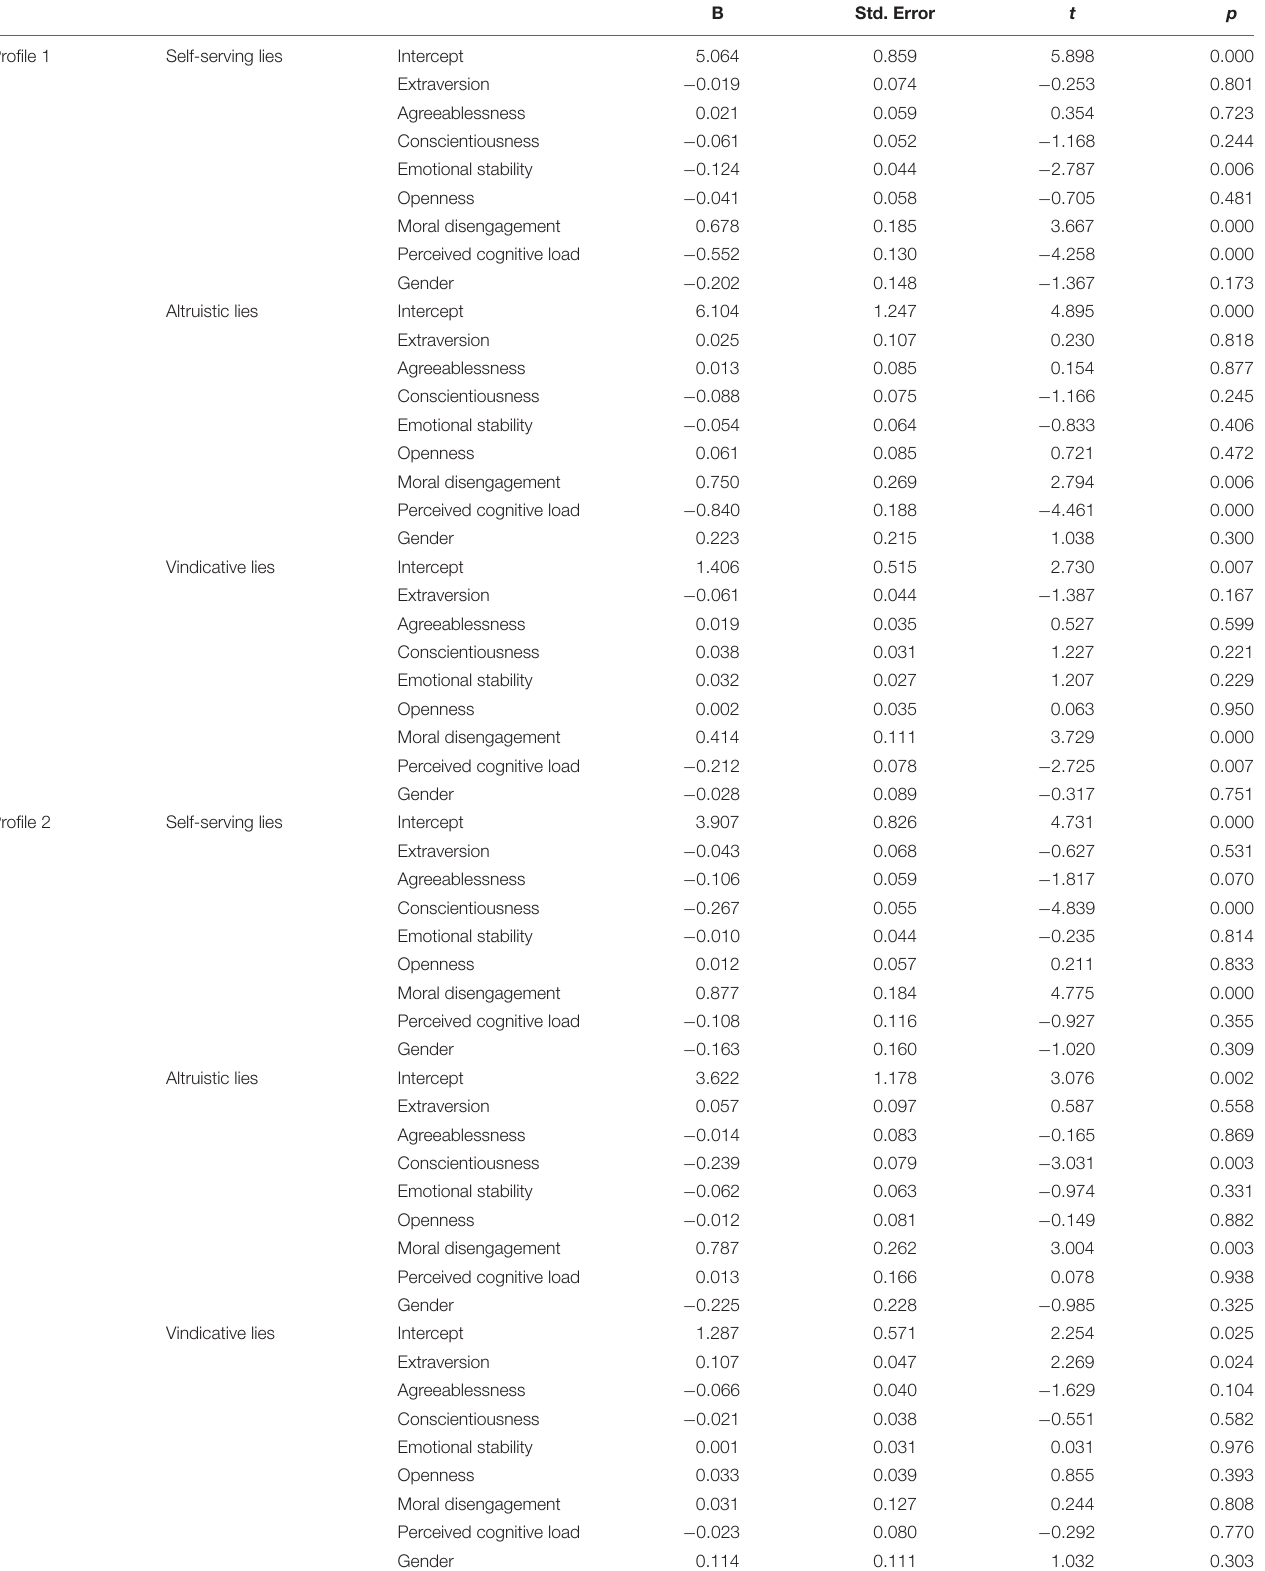
TABLE 3 | Multiple regression with personality, morality, and perceived cognitive load as predictors and LiES scores as the outcome variables for each profile. B Std. Error t p